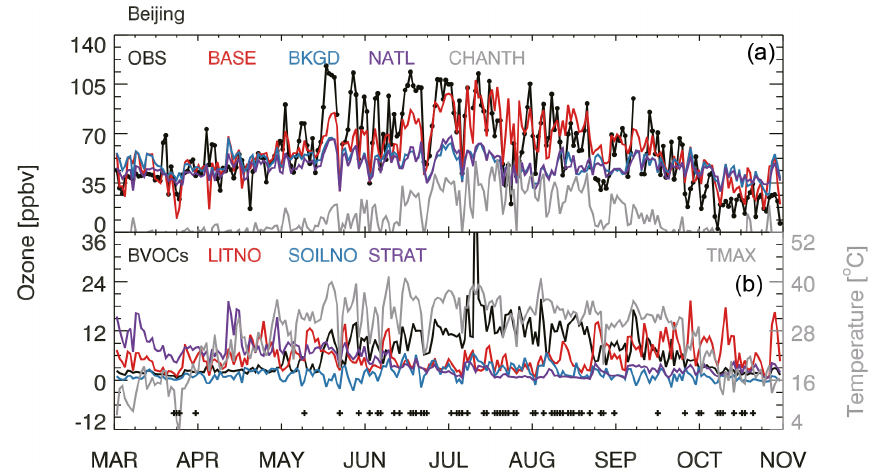
Figure 7. Time series of observed and simulated daily MDA8 ozone concentrations and source attributions at Beijing in March–October 2017. Panel (a) shows observed MDA8 ozone (OBS, black), simulated ozone (BASE, red), estimated background ozone (BKGD, blue), natural ozone (NATL, purple), and domestic anthropogenic ozone (CHANTH, grey). Panel (b) shows the ozone enhancement from biogenic VOCs (BVOCs, black), lightning NO x (LITNO, red), soil NO x (SOILNO, blue), and the stratosphere (STRAT, purple). The estimation of ozone source attributions is described in the text. Also shown is daily maximum 2m air temperature (TMAX, grey, right y axis) from the GEOS-FP data. The black pluses denote days with precipitation recorded from GEOS-FP data.